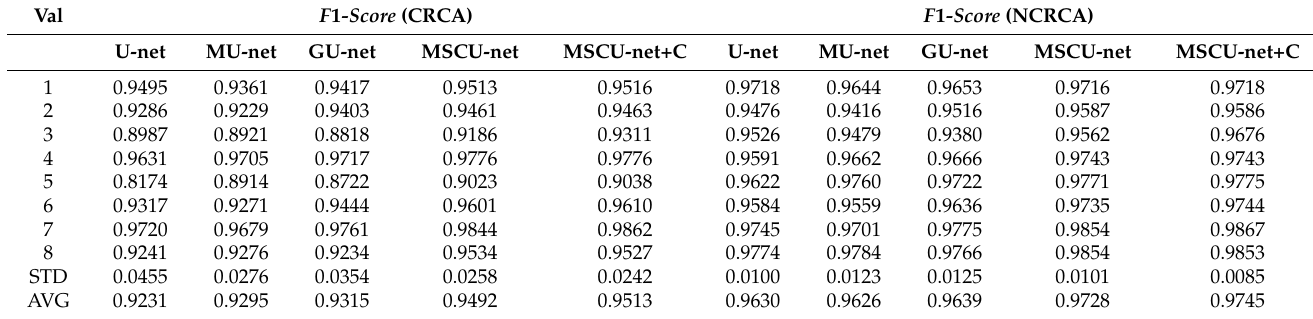
Table 4. Comparison of ablation experiments on pixel-wise